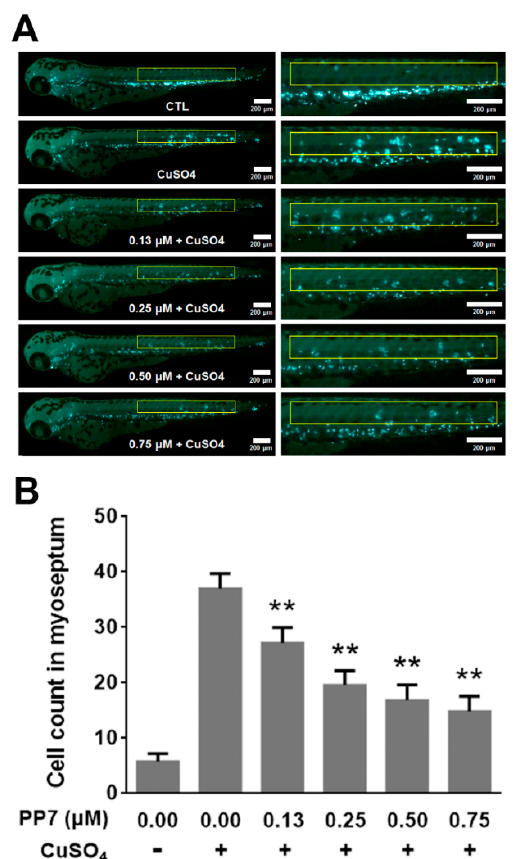
Figure 6. PP7 affects CuSO 4 induced inflammation in zebrafish. ( A ) BACmpx::GFP transgenic zebrafish larvae at 3 days post-fertilization (dpf) were treated with indicated concentrations of PP7 for 1 h prior to CuSO 4 treatment (20 µ M CuSO 4 for 1 h) and were monitored for neutrophils present at the myoseptum. Scale bars represent 200 µ m. ( B ) Quantification of numbers of neutrophils recruited to the lateral line after CuSO 4 treatment. Data are represented as means ± SD from three independent experiments. n = 10/group, ** p < 0.01 as compared with CuSO 4 -treated alone.